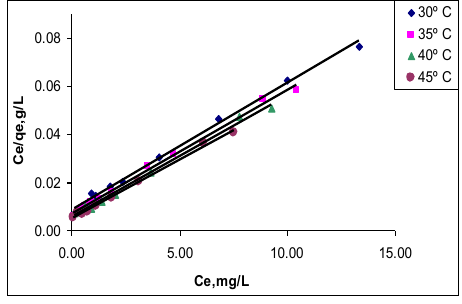
Figure 5 - Langmuir adsorption isotherm plot for the adsorption of AV49 dye onto PAC (adsorbent dosage, 100mg; pH, 3.4; agitation time, 100